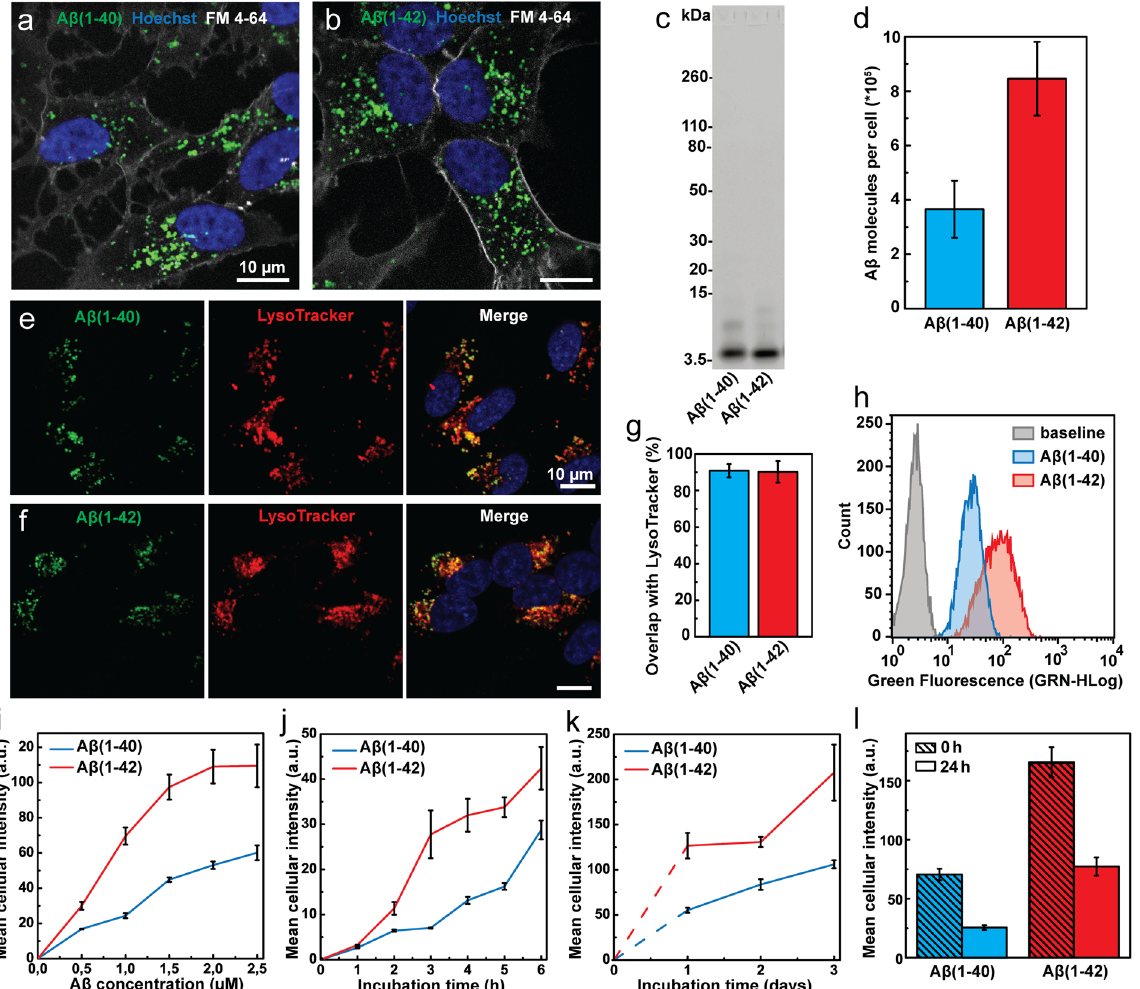
Figure 1. Imaging and quantification of the cellular uptake of A β (1–40) and A β (1–42) in SH-SY5Y cells. ( a , b ) Confocal microscopy images showing uptake of HF488-labelled A β (1–40) ( a ) and A β (1–42) ( b ) (green) after 24 h incubation at 500 nM peptide concentration. The cell nuclei (blue, Hoechst 33342) and outer cell membrane (grey, FM 4–64) were stained immediately prior to imaging. ( c ) SDS-PAGE of A β (1–40) and A β (1–42) solutions. The major band corresponds to HF488-labelled A β (1–40) and A β (1–42) monomers (4.7 and 4.9 kDa respectively). ( d ) Confocal imaging based quantification of the cellular uptake of A β (1–40) and A β (1–42) following incubation with 1 µ M A β (1–40) or A β (1–42) for 8 h. The average uptake of A β molecules per cell was 3.7e 5 ± 1.1e 5 for A β (1–40) and 8.5e 5 ± 1.6e 5 for A β (1–42). The data is presented as mean ± SD from the analysis of 16 images from two separate culture dishes. Each image showed on average 25 cells. ( e – g ) Co- localisation analysis of confocal microscopy images ( e , f ) showing A β signal overlap with LysoTracker Deep Red. ( g ) Mander’s coefficient ± SD for the overlap of A β with Lysotracker Deep Red was calculated by analysis of 21 images with ~5 cells in each image (from three separate samples). The cells were incubated for 24 h, washed and incubated for an additional 5 h prior to imaging. ( h ) Flow cytometry histograms showing the cellular uptake of A β (1–40) and A β (1–42) following incubation with 1 μ M peptide for 5 h. The baseline, representing cellular autofluorescence, is shown for comparison. ( i ) Uptake of A β (1–40) and A β (1–42) as function of peptide concentration following 5 h of incubation. ( j , k ) Uptake of A β (1–40) and A β (1–42) as function of incubation time at a peptide concentration of 500 nM. ( l ) Clearance of intracellular A β (1–40) and A β (1–42). Cells were loaded by incubation with 500 nM peptide for 24 hours (“0 h”), washed and incubated for an additional 24 h (“24 h”). The data has been corrected for cell division. Uptake in ( i – l ) is reported as mean cellular fluorescence intensity ± SD of the total number of gated live cells in three replicates. Data were corrected for baseline contributions by subtracting the mean cellular